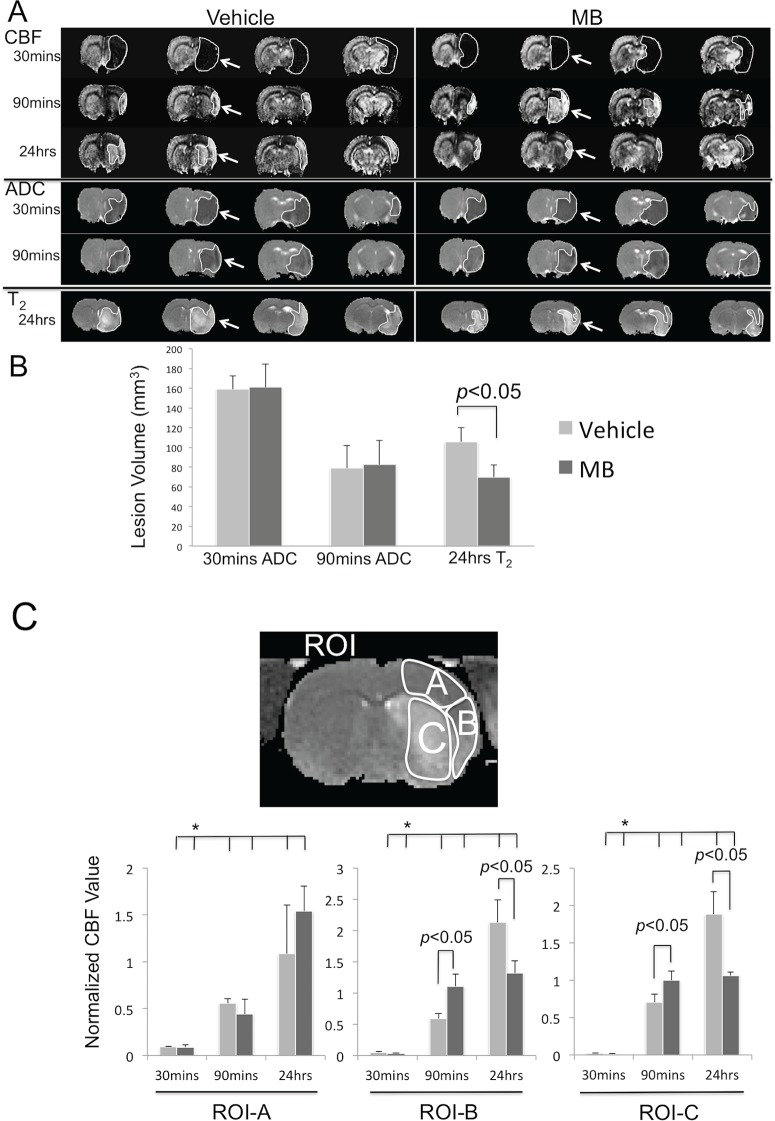
MB reduces infarct volume and CBF deficit.
(A) Representative ADC, CBF and T2 maps, (B) lesion volumes, and (C) CBF value (normalized against the value at contralateral hemisphere) from three regions of interest (insets) at multiple time points post-occlusion of the vehicle and MB groups. The ROIs included: (ROI-A) the perfusion-diffusion mismatch area typically salvaged by reperfusion, (ROI-B) the perfusion-diffusion mismatch area typically not salvaged by reperfusion, and (ROI-C) the ischemic core. The ROIs and arrows delineated the regions of abnormalilties. Values are mean±SEM, n = 5 in each group. *p<0.05 indicates statistical difference from data at 30 mins.